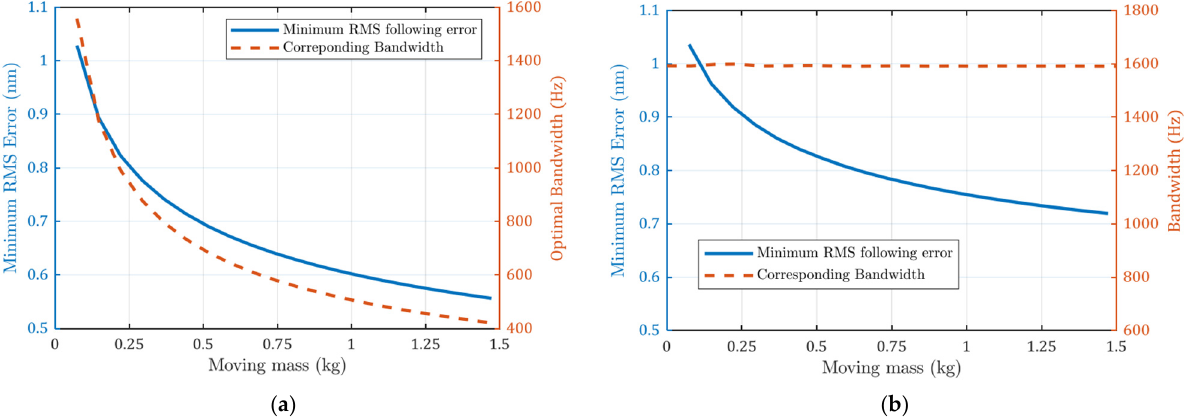
Figure 11. ( a ) Errors with variable optimal bandwidth; ( b ) errors with constant bandwidth. Minimum achievable positioning error decreases with larger moving masses.